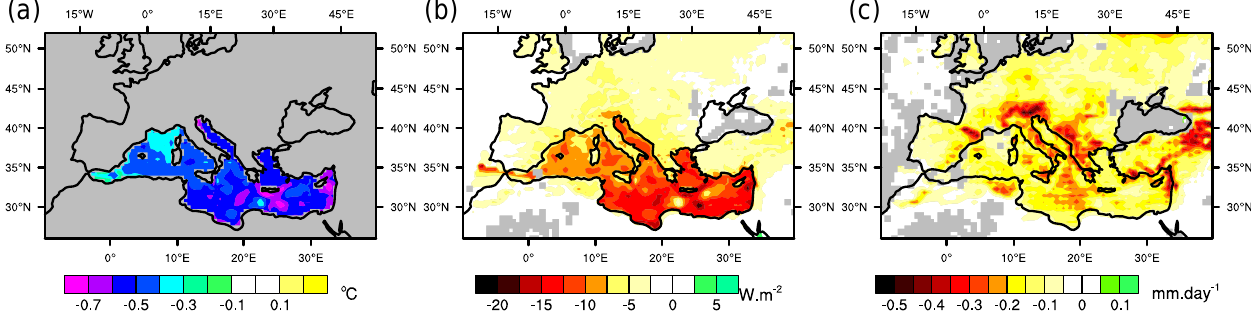
Figure 29. Annual average difference in (a) sea surface temperature (SST), latent heat loss (b) and precipitation (c) over the period 2003– 2009 between a simulation ensemble including aerosols and a second one without any aerosol.